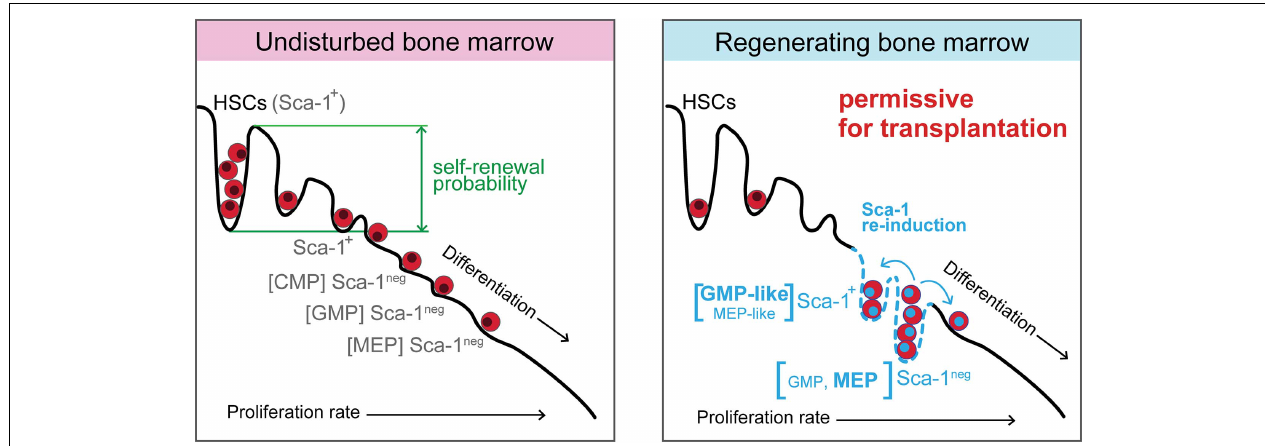
FIGURE 9 | Model of regenerating hematopoiesis driven by activated progenitor cells, which maintain hematopoiesis permissive for transplantation of hematopoietic cells. In the intensively regenerating hematopoiesis that has already resumed blood cell production, the expanded activated progenitor cells diminish the differentiation pressure on multipotent progenitors and stem cells. A similarity can be found in such rearranged hierarchy of immature hematopoietic cells with the period of embryonic hematopoiesis when erythro-myeloid progenitors produce blood cells in the absence of stem cells. The hematopoiesis still remains permissive for the engraftment of transplanted cells, although it became the significant source of mature blood cells.